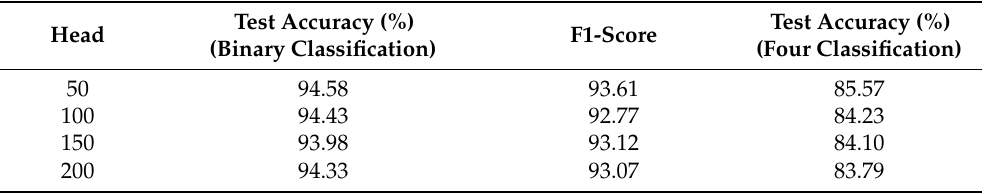
Table 6. Comparison of different epoch times ablation